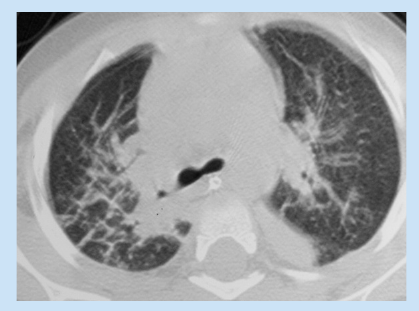
Fig. 1a. Figs .1a and b. High resolution CT scan findings of the chest. (a) Upper zone patchy areas of interlobular septal thickening, right worse than left, with associated areas of air-space disease.